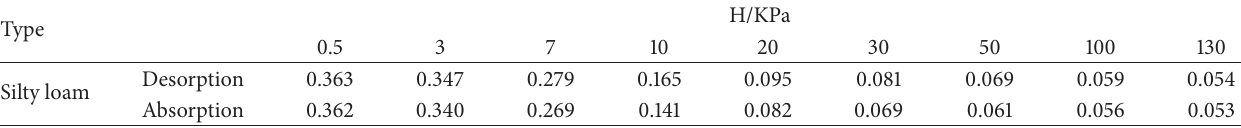
Table 1: Desorption and absorption experimental data of silt